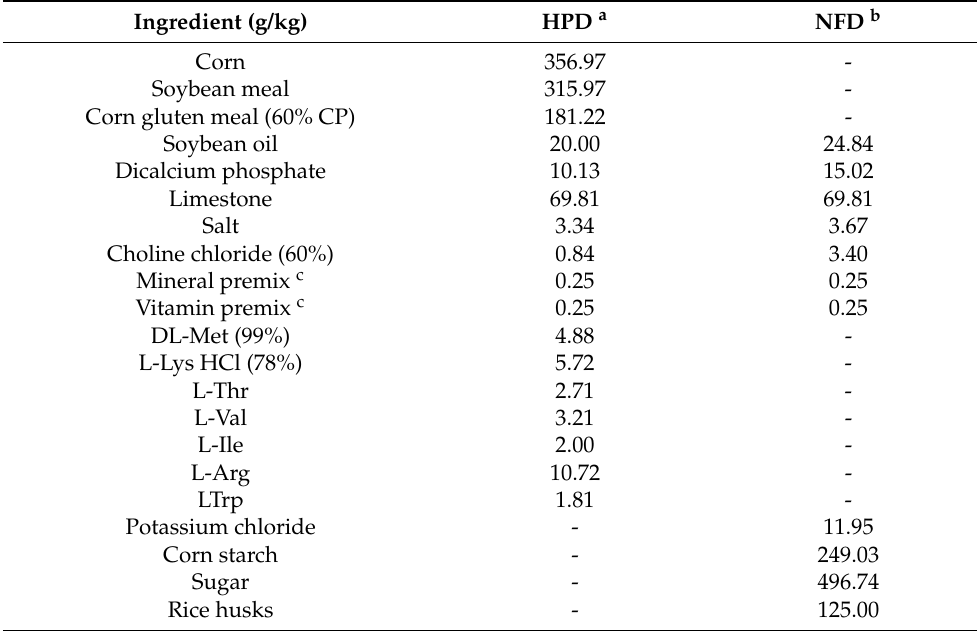
Table 1. Composition (g/kg) of the diets used in the lysine assay.